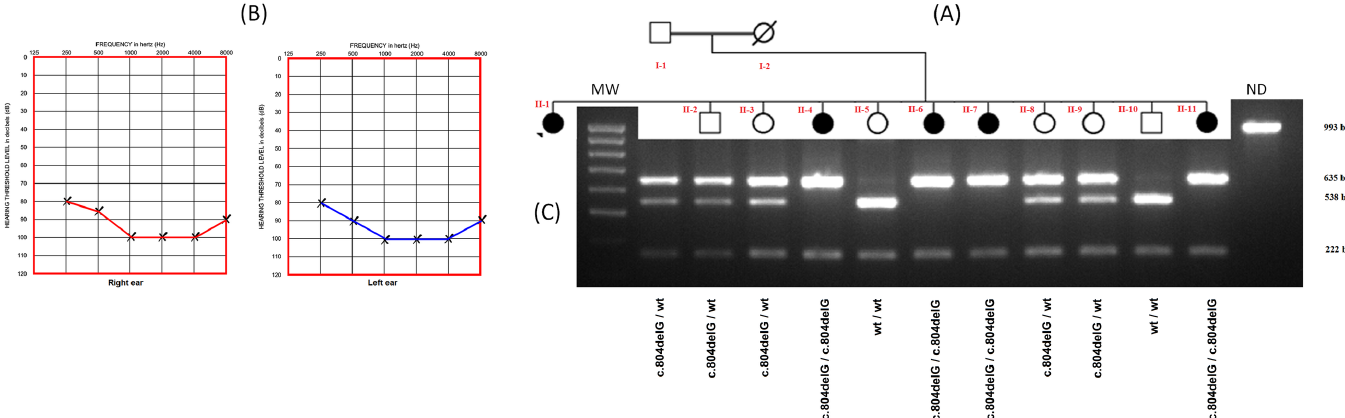
PLOS ONE | https://doi.org/10.1371/journal.pone.0185281 September 25,